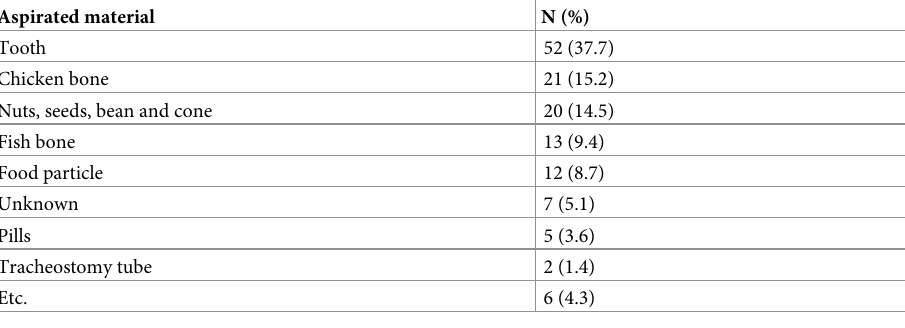
Table 5. The type of tracheobronchial foreign